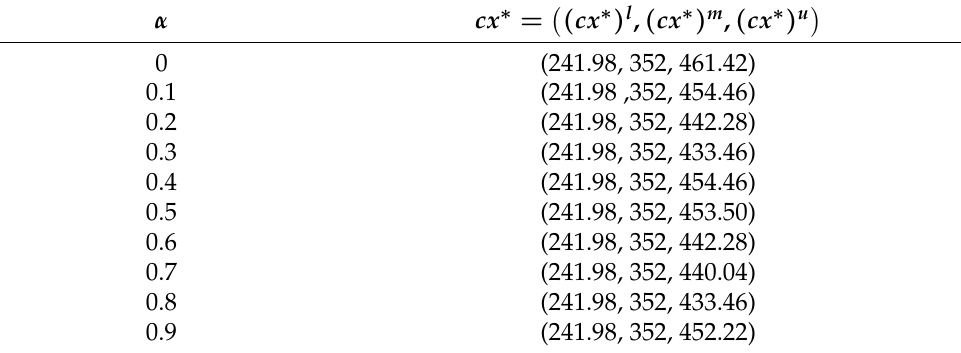
Table 3. Results of example 3 with different alpha